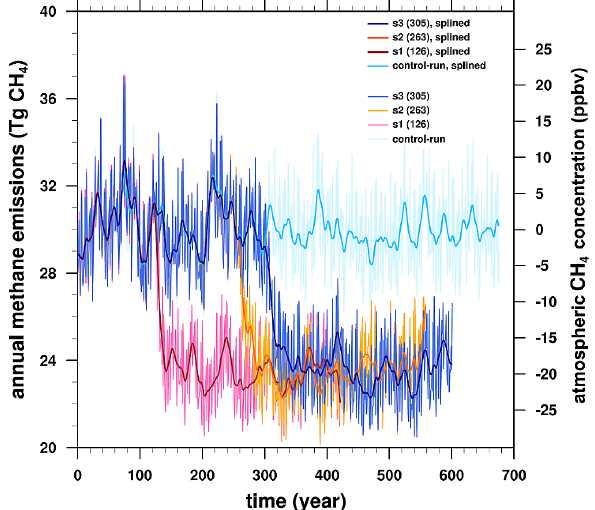
Fig. 6. Total methane emission from northern peatlands for the en- semble runs with freshwater input forcing (s1 to s3) and the control run (cyan). The resulting total methane flux was scaled to reach an average value of 30TgCH 4 per year during the control run. Annual emissions are shown by light colours and splines through the annual data by dark